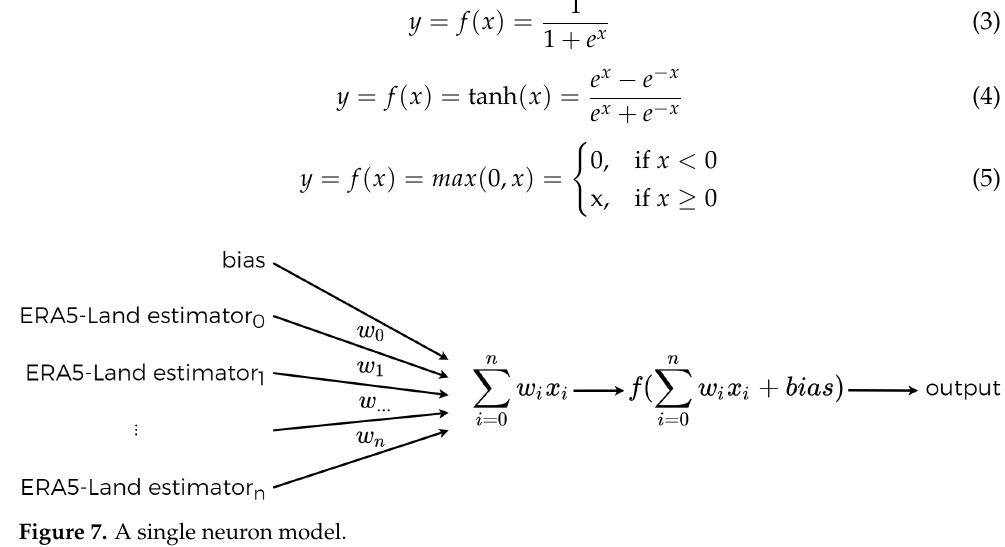
Figure 7. A single neuron